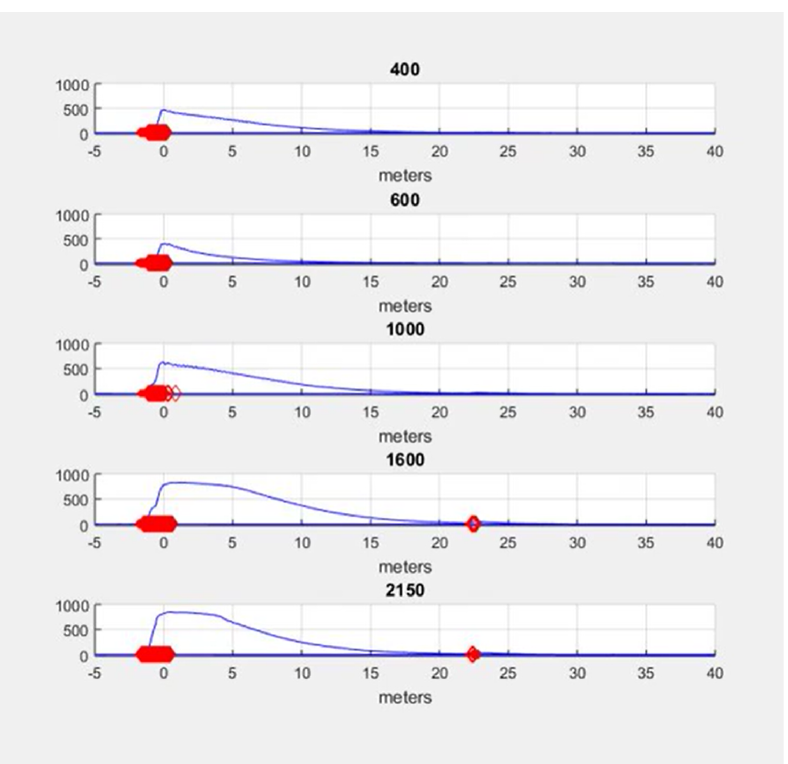
Figure A1. Single cluster of five voltages. Voltage is displayed in arbitrary units. 2150 is the highest voltage used, beyond that the detector is unstable. The quantum detection efficiency is about 40% for voltage of 2150 and gets lower as the voltage is decreased. The x-axis is calibrated to show the range based on Equation (1) and the measurement of the refraction index in Figure